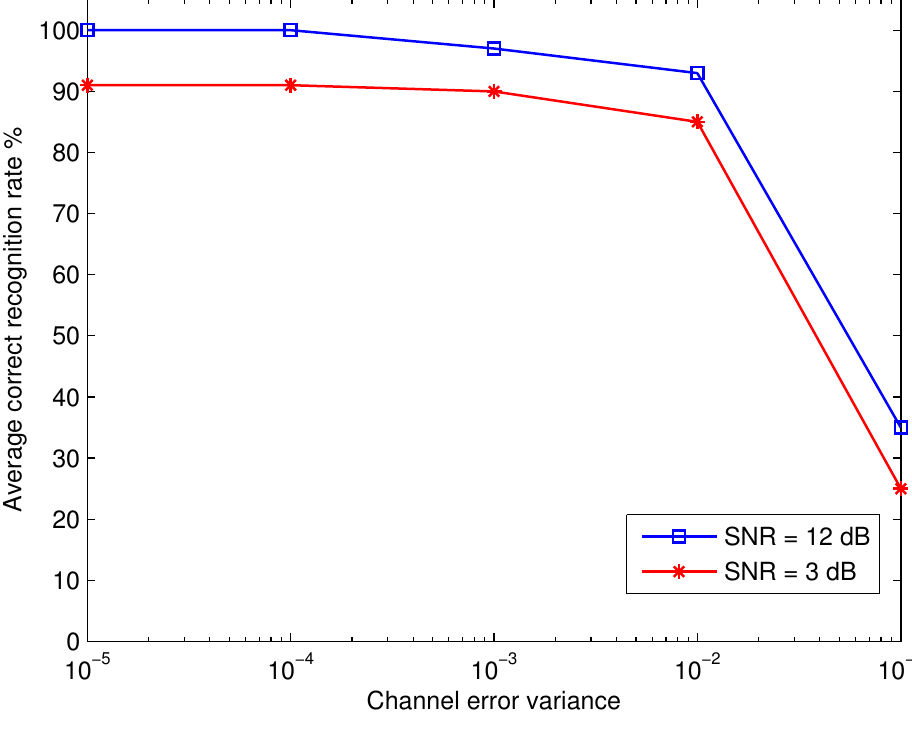
Figure 8. Effect of channel estimation error on the performance of the proposed scheme.